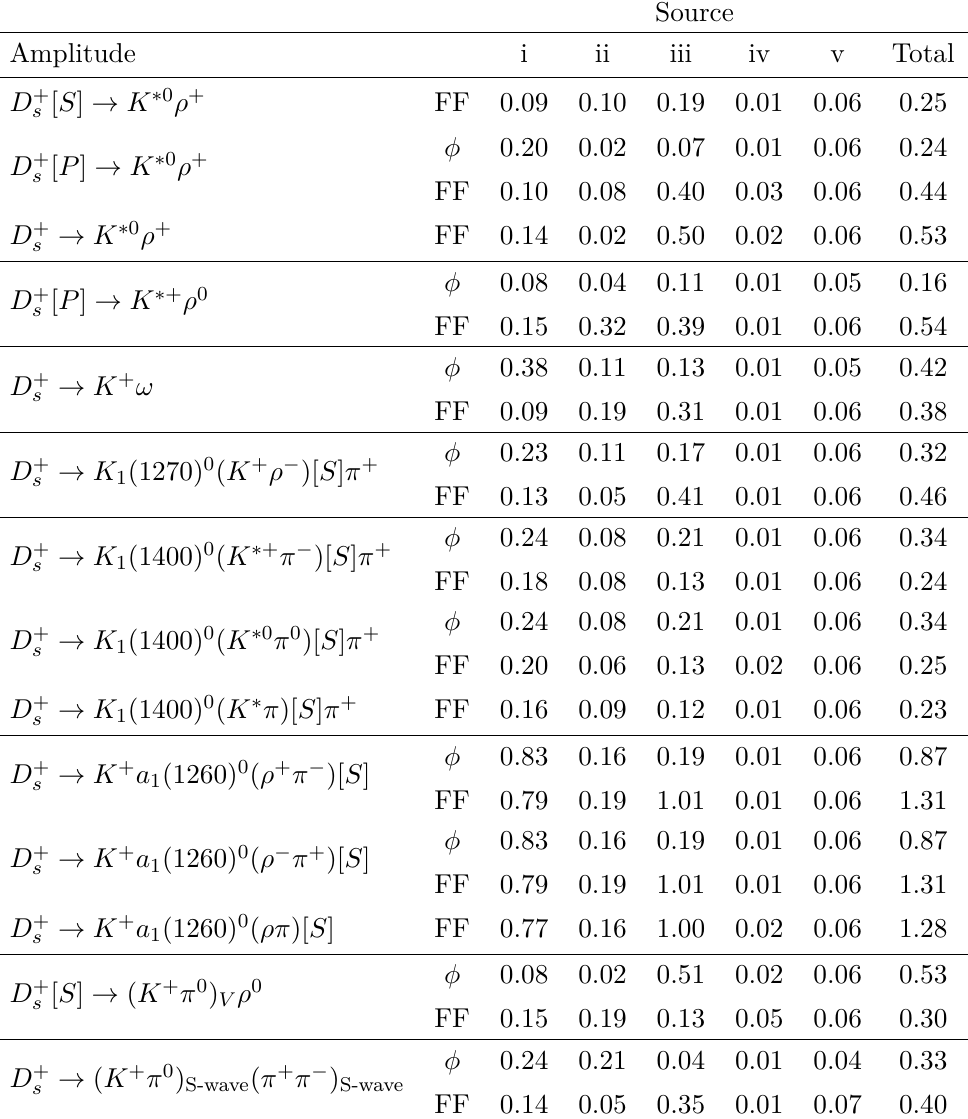
Table 9 . Systematic uncertainties on the phases and FFs for different amplitudes in units of the corresponding statistical uncertainties. (i) Amplitude model, (ii) effective radius, (iii) background, (iv) experimental effects, (v) fit